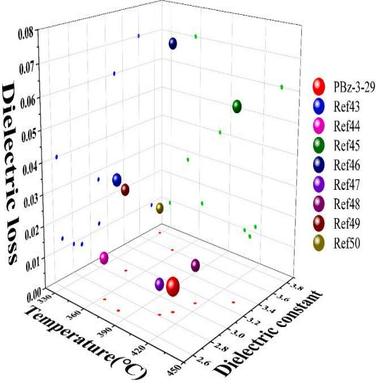
Comparison of the thermal and dielectric properties of polybenzoxazine PBz-3-29 with other common resins.